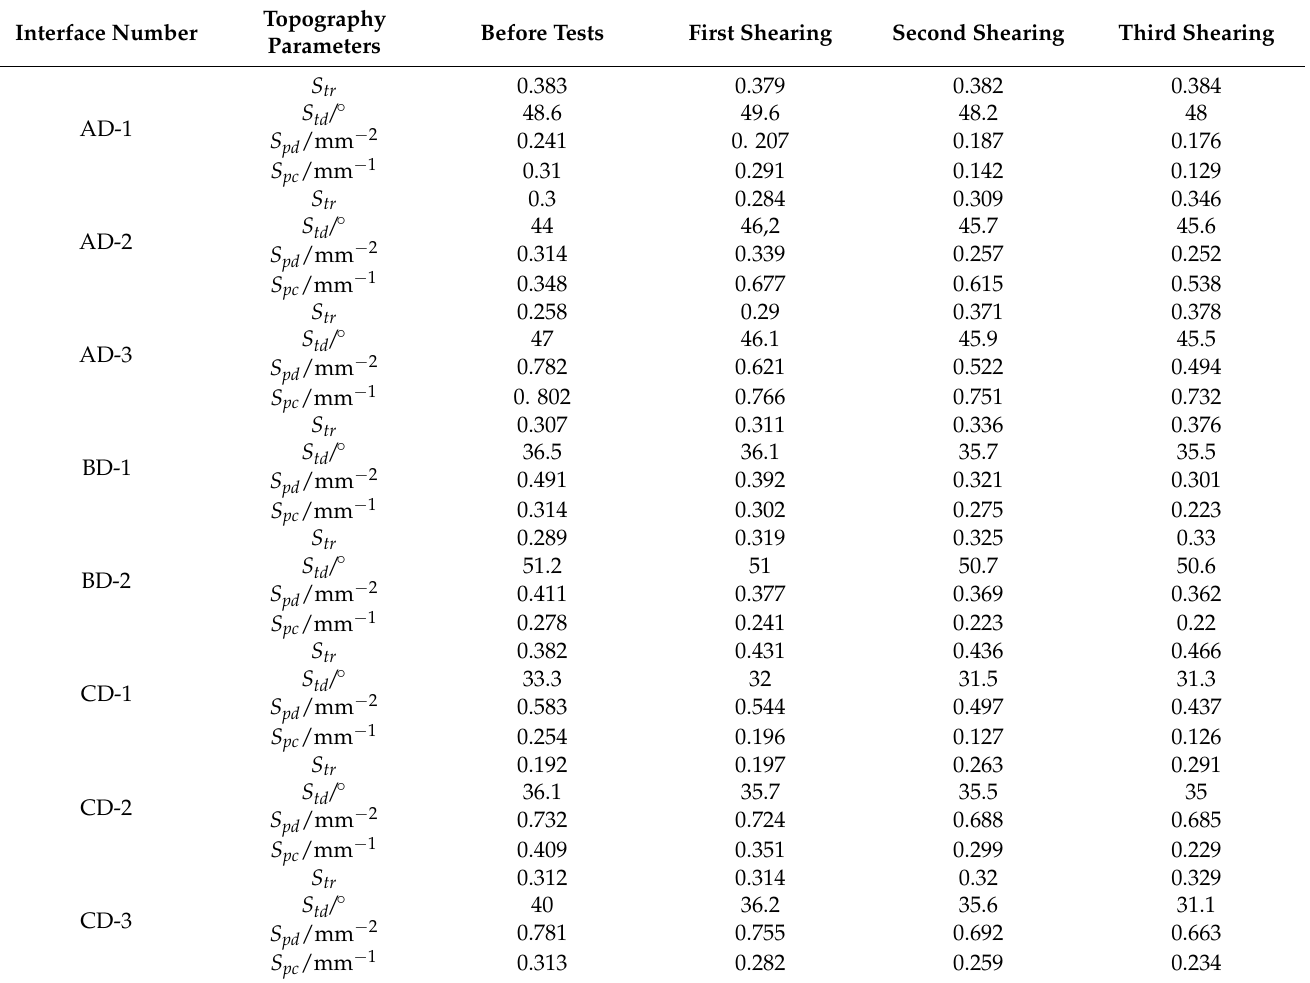
Table 5. Texture characteristics of surface morphology and peak point characteristics